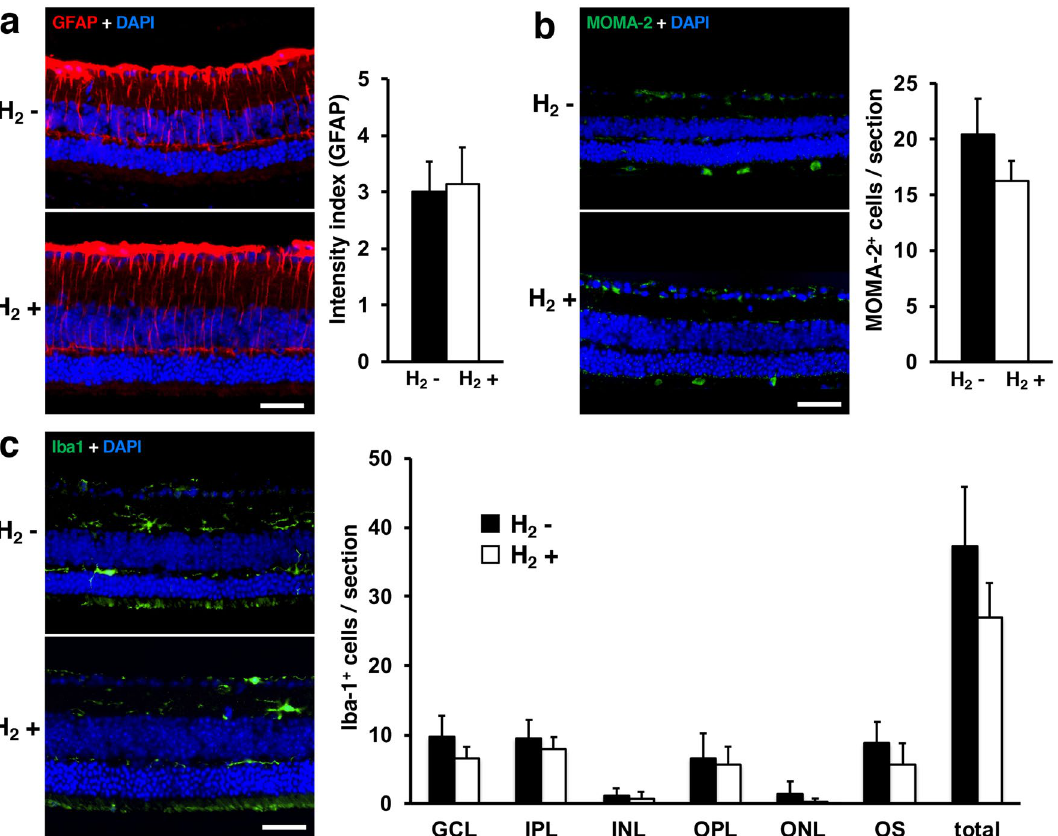
Figure 7. Immunohistochemical analysis of GFAP, MOMA-2, and Iba-1. Immunohistofluorescence for GFAP ( a ), MOMA-2 ( b ), and Iba-1 ( c ) are shown in representative retinal specimens with/without H 2 water (each group: n = 4). We found no significant difference between with/without H 2 water (GFAP: p = 0.64, MOMA-2: p = 0.06). ( c ) Mean numbers of microglial cells counted in each retinal layer and total. No significant differences between with/without H 2 water were evident. Layers were defined as: ganglion cell layer (GCL); inner plexiform layer (IPL); inner nuclear layer (INL); outer plexiform layer (OPL); outer nuclear layer (ONL); and layer of the photoreceptor outer segments (OS). Scale bar 50 μm. Bars depict means ± standard deviation